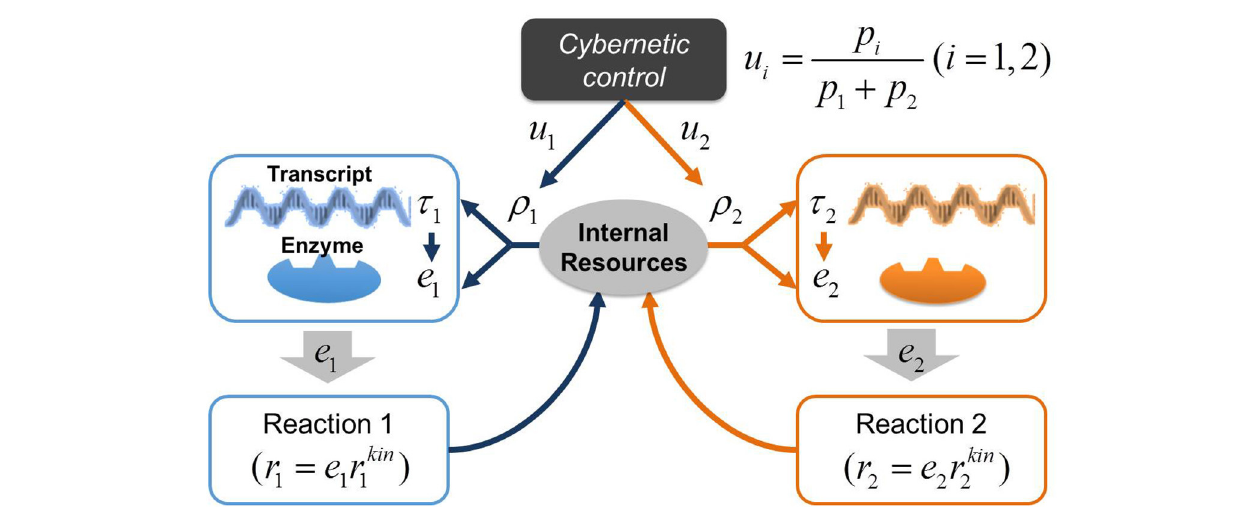
FIGURE 2 | A schematic representation of the control structure in the RSCM. The variable u i controls the synthesis of resource ( ρ i ) based on the contribution of individual reactions to the postulated metabolic objective (i.e., return-on-investment p i , e.g., p i = r i ); the synthesis of transcript ( τ i ) is subsequently determined by ρ i ; the synthesis of e i is determined by both τ i and ρ i ; the enzyme e i , in turn, catalyzes reaction ( r i